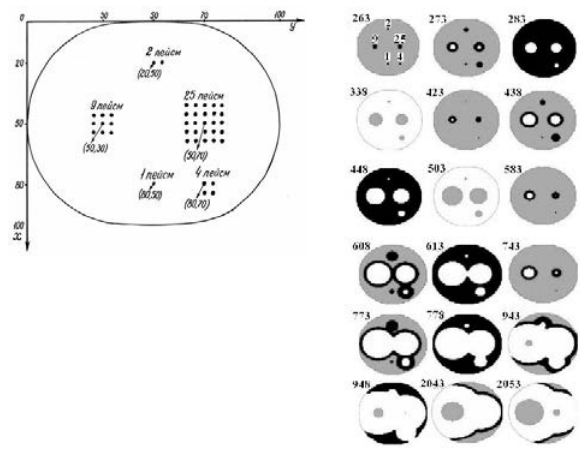
Fig. 6. The scheme of the computational experiment for studying the interaction of the pacemakers of the sinoatrial node is shown on the left, the results of the computational experiment are shown on the right.